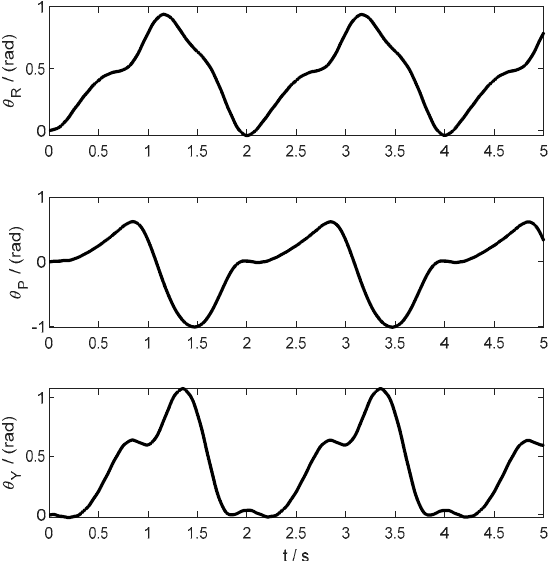
Figure 7. The angle of the platform in the simulation of sine trajectory. The sine trajectory tracking error of the simulation with traditional PID controller, SMC controller, FTSMC controller and NNFTSMC controller is presented in Figure 8.